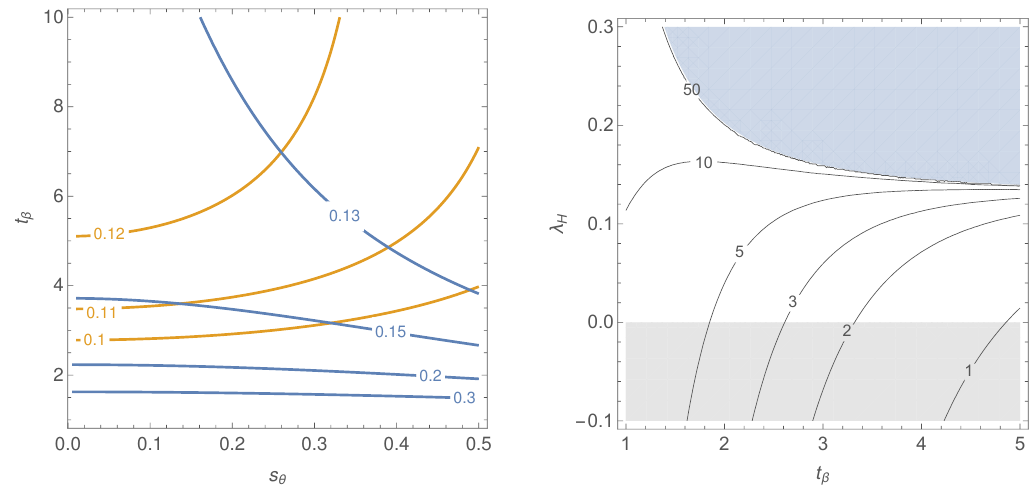
Figure 2 . Left panel: values of (cid:21) H . Blue (yellow) contours represent the case m 2 ( m 2 =f 2 = 1). Right panel: the contours show the value of (cid:3) TC = 4 (cid:25)f in TeV corresponding H to a 1 TeV heavy Higgs mass. The region (cid:21) H < 0 is excluded by the requirement of stability of the potential. For (cid:3) TC ! 1 the curves lie on top of the (cid:3) TC = 50 TeV contour so the shaded area results in no viable solutions. More details in the text.